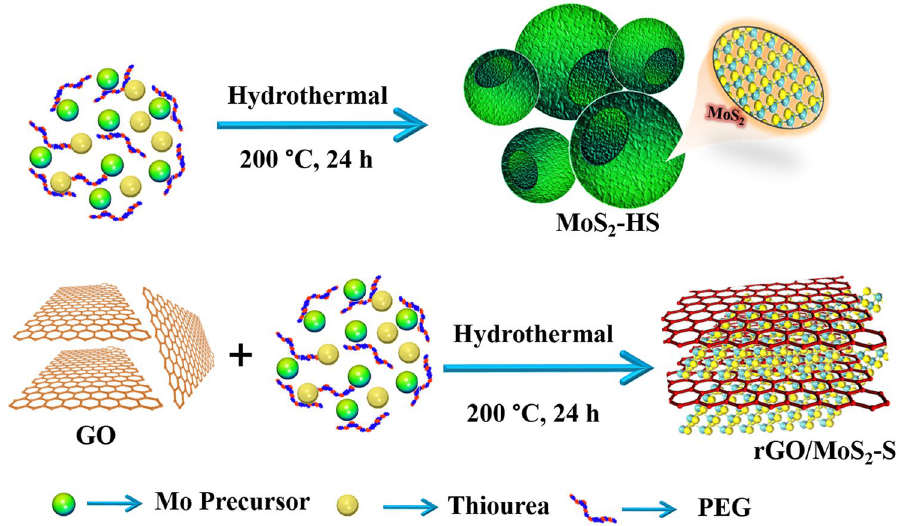
Figure 1. The schematic presentation for the synthesis of MoS 2 -HS and rGO/MoS 2 -S